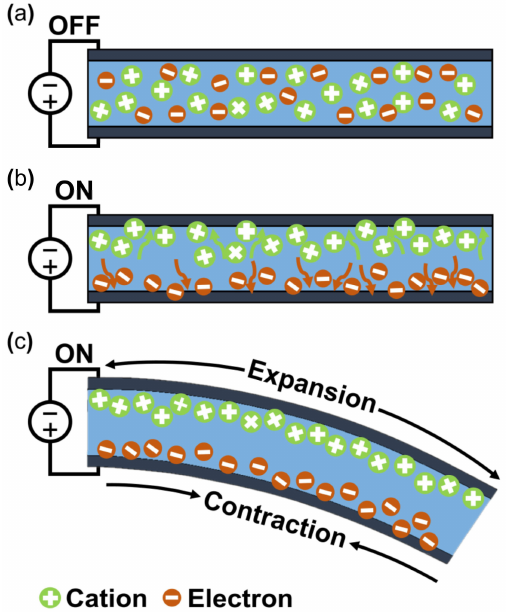
Figure 3. Actuation principle of IPMC. ( a ) Initial state. ( b ) Ion migration state. ( c ) Bend state. Adapted from Ma et al. [30] with permission from Wiley-VCH Verlag GmbH, Copyright